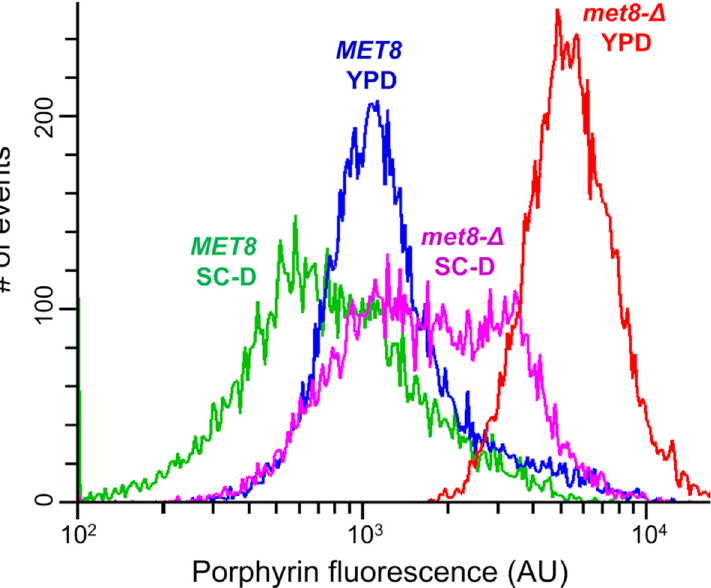
Figure 3. Distribution of cells according to porphyrin fluorescence in cultures of O. parapolymorpha strains with wild-type ( MET8 ) and deletion ( met8- Δ ) MET8 alleles, which were grown in the syn- strains with wild-type ( MET8 ) and deletion ( met8- ∆ ) MET8 alleles, which were grown in the synthetic thetic SC-D or complex YPD medium. SC-D or complex YPD